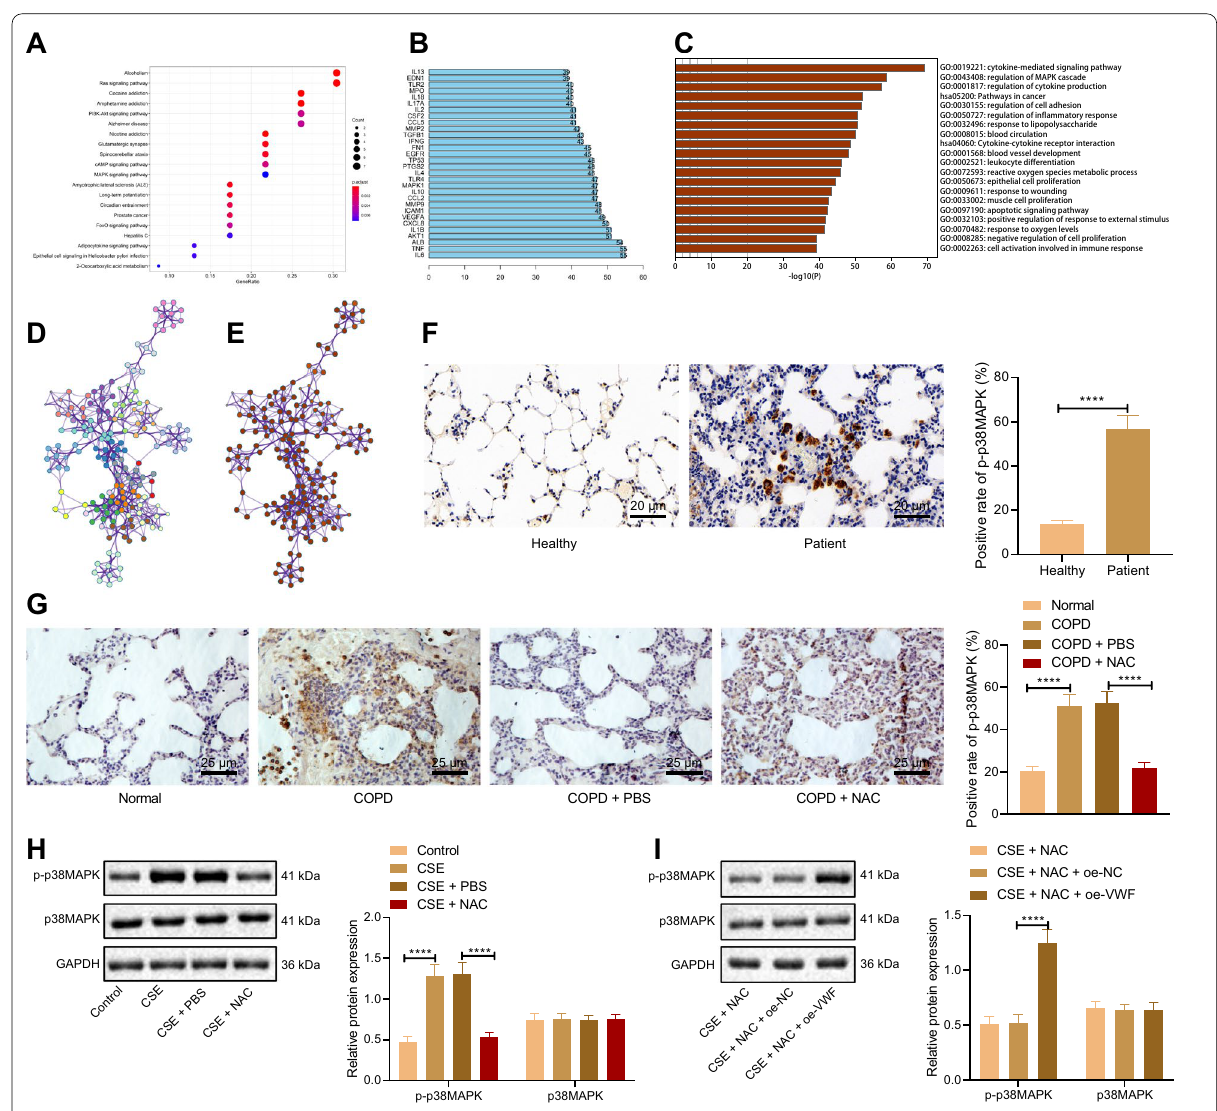
Fig. 4 NAC inhibits VWF expression to reduces p38 MAPK phosphorylation. A KEGG enrichment analysis of NAC target genes. The abscissa represents the number of involved genes, and the ordinate represents the enrichment entry name. B the number of genes from PPI network interacted with genes. C GO enrichment analysis of COPD target genes. D GO enrichment analysis of biological pathways related to COPD target genes. E P value of GO enrichment analysis of biological pathways related to COPD target genes. F The extent of p38 MAPK phosphorylation in the lung tissues of healthy individuals and COPD patients measured by immunohistochemistry (n 10). G The extent of p38 MAPK phosphorylation in = lung tissues of COPD rats measured by immunohistochemistry (n 10). H The extent of p38 MAPK phosphorylation and protein levels of and p38 = MAPK in cells determined using Western blot analysis. CSE cells were transduced NAC and oe-VWF (with NAC and oe-NC as control). I The extent of p38 MAPK phosphorylation and protein levels of p38 MAPK in cells determined using Western blot analysis. **** p < 0.0001. Data are shown as the mean standard deviation of three technical replicates. Data between two groups were compared by independent sample t test. Data among ± multiple groups were compared by one-way ANOVA with Tukey’s post hoc